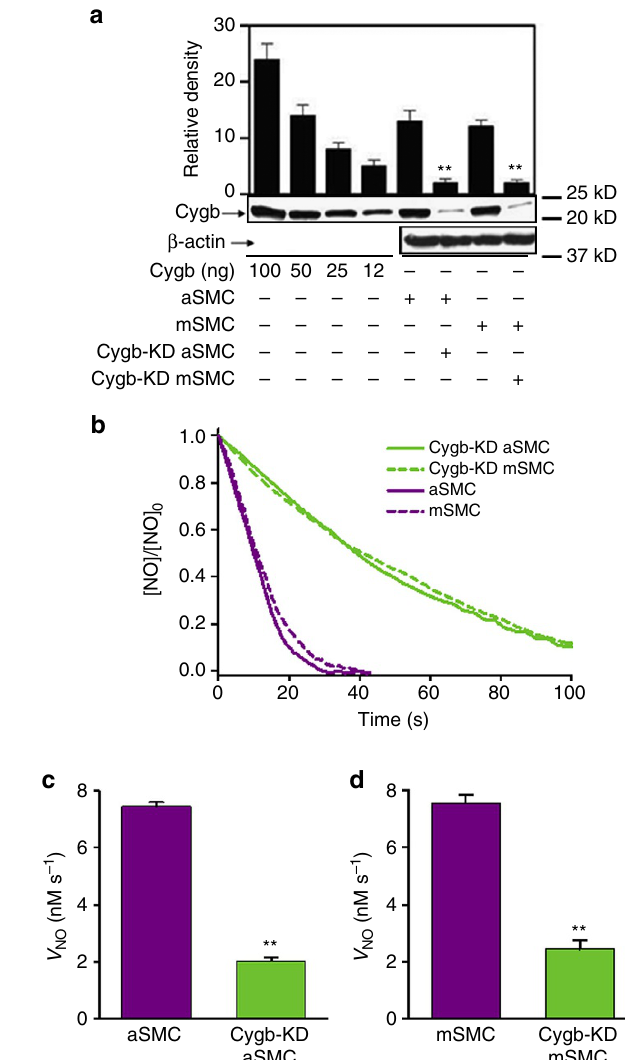
Figure 3 | Knockdown of Cygb in rat aortic and mesenteric smooth muscle cells (SMCs). ( a ) Level of Cygb in rat aortic SMCs (aSMCs) and rat mesenteric SMCs (mSMCs) was estimated by quantitative immunoblotting. The first four bands are pure Cygb at four different amounts. Bands 5 and 6 are total cellular proteins from rat aSMCs and the related Cygb siRNA-treated cells ( Cygb -KD aSMC), respectively; and bands 7 and 8 are rat mSMCs and the related Cygb siRNA-treated cells ( Cygb -KD mSMC), respectively. Positions of nearest molecular weight markers are shown. ( b ) Plots of the rate of NO decay by 7 (cid:2) 10 6 SMCs per ml (violet solid line: aSMC, violet dashed line: mSMC) and 7 (cid:2) 10 6 Cygb -KD SMCs per ml (green solid line: Cygb -KD aSMC, green dashed line: Cygb -KD mSMC) versus time after NO was injected into the solution to achieve an initial concentration of 0.5 m M. Means and standard errors of the rate of NO decay by SMCs and Cygb -KD SMCs from aorta ( c ) and mesenteric artery ( d ). Error bars: mean ± s.e.m., n ¼ 3–5 per group, ** P o 0.01